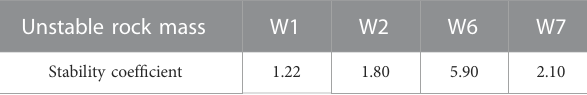
TABLE 6 Sliding stability coef fi cient of the unstable rock mass.